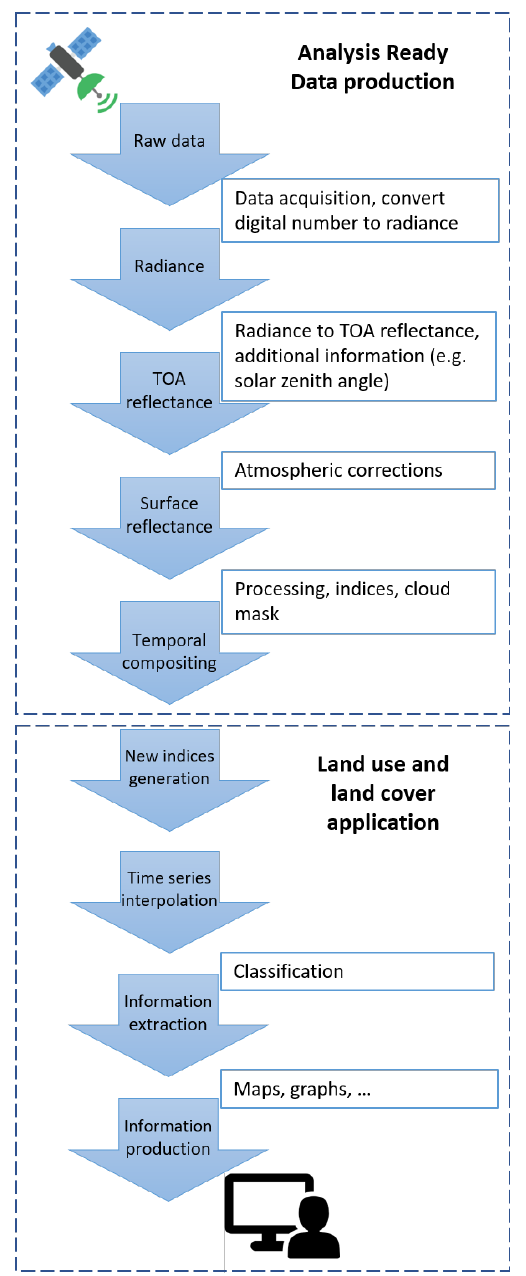
Figure 1. Data cube generation and LULC classification